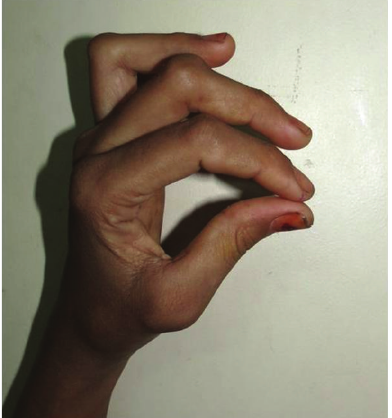
Figure 2: Showing swan neck deformity of left hand.